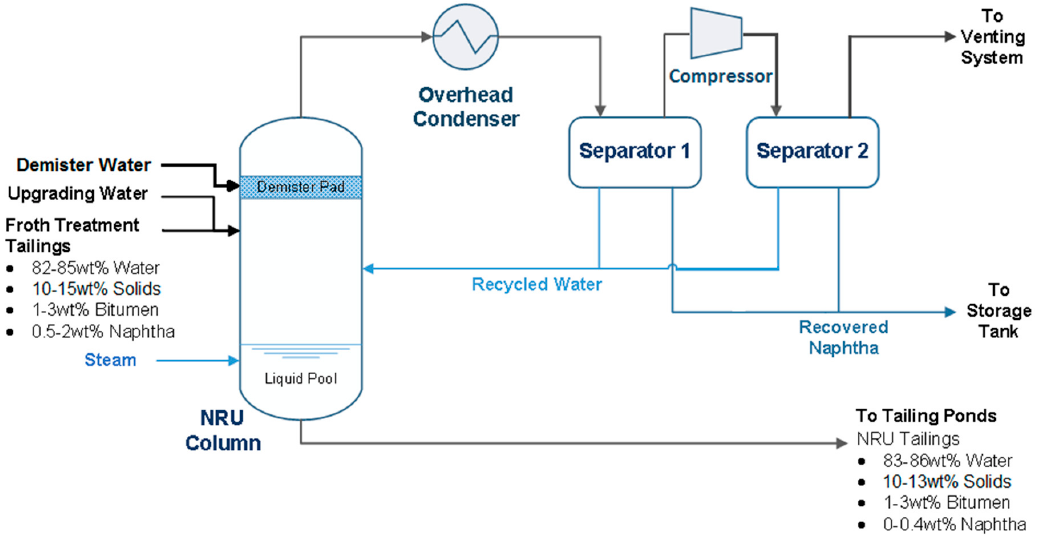
Figure 2. Process flow diagram of naphtha recovery unit.